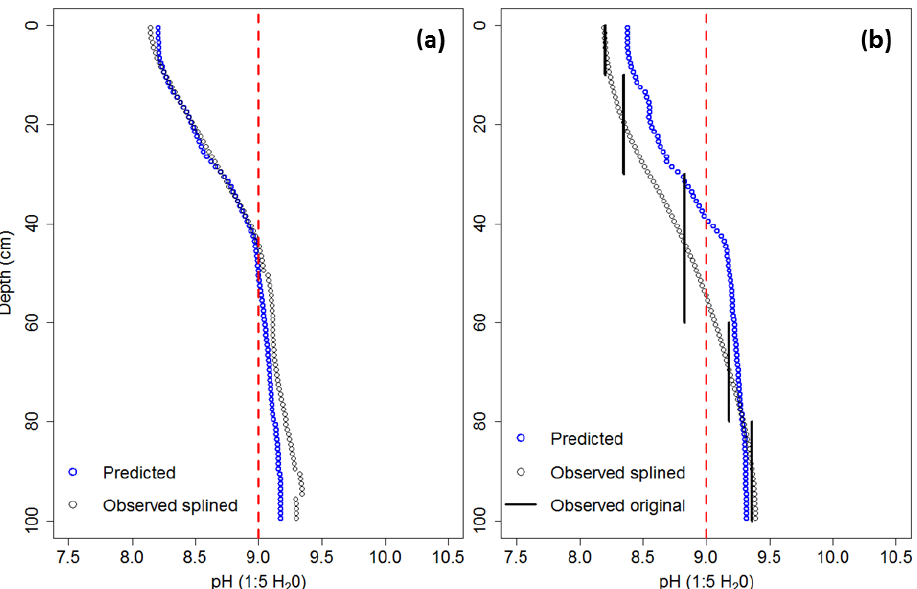
Figure 7. Observed soil pH data splined using equal-area quadratic smoothing splines (black circles), and independently validated predicted data from the random forest model (blue circles) for the mean of all soil sites ( a ) and an example soil profile, Site 16 ( b ). The observed soil pH data at the sampled depth increments (solid black lines) for Site 16 is also shown in ( b ). The red dashed line represents the pH threshold of nine (H 2 O).